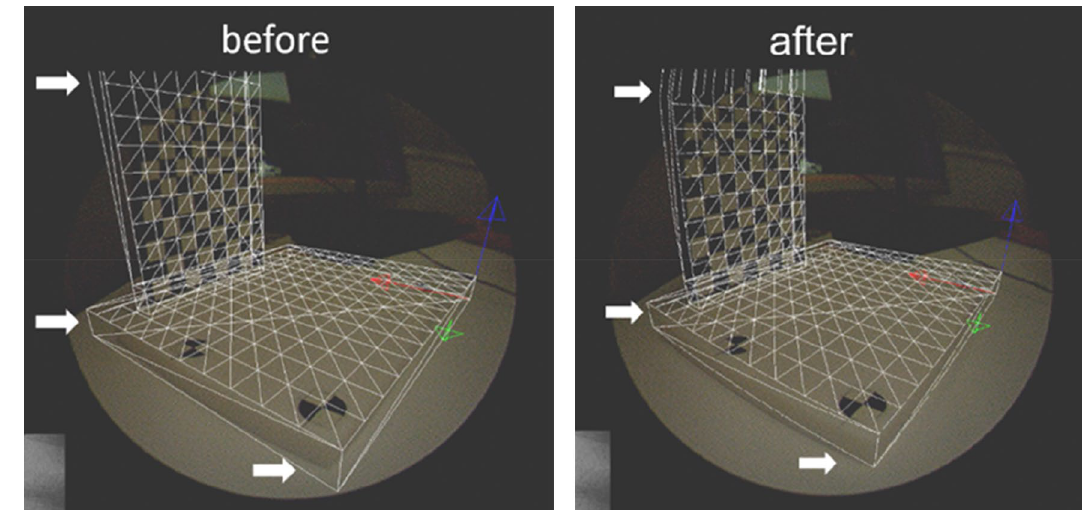
Figure 3. Reverse distortion correction using lens distortion matrix. White arrows show differences before and after correction. Appropriate distortion of the shape on the monitor was